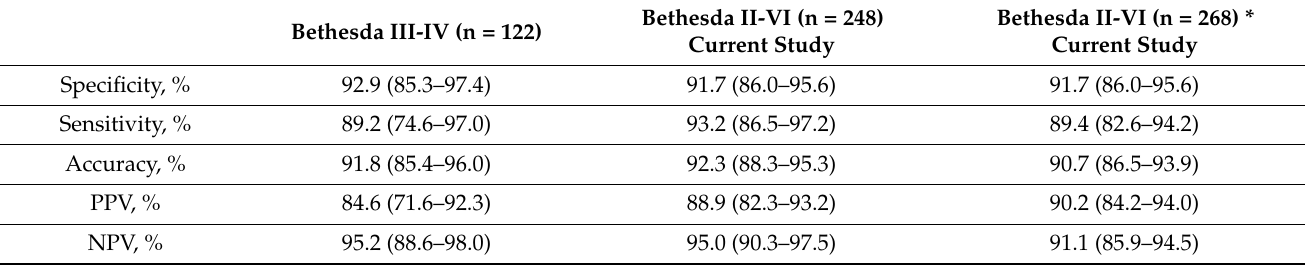
Table 3. Diagnostic characteristics of the molecular classifiers for malignant tumors (with a 95% confidence interval) from the current and previous